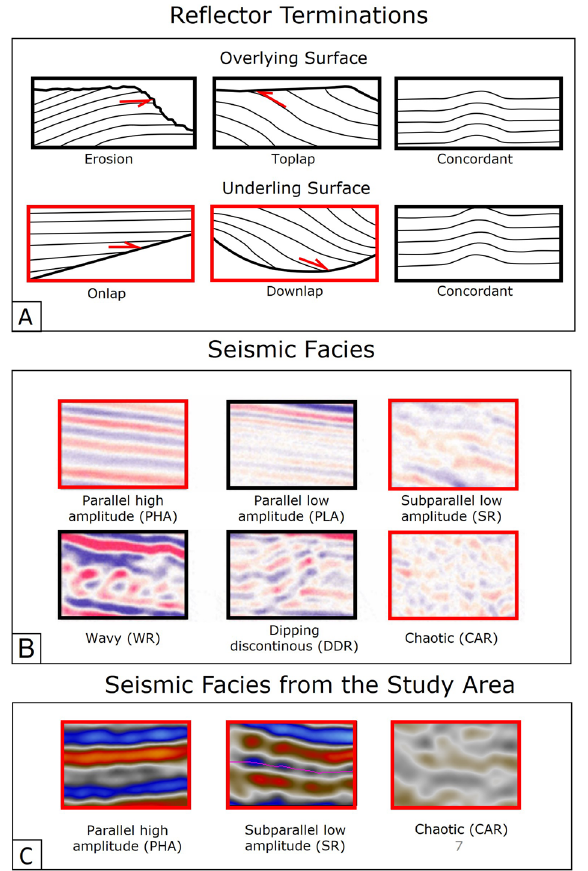
Fig. 8 A Reflector termination classification and B seismic facies and after Mitchum et al. (1977). Marked in red are the most frequently occurring features in this study: parallel high amplitude (PHA), subparallel low amplitude (SR), and chaotic (CAR), as well as onlap and downlap seismic surfaces. C Examples of seismic facies observed in this